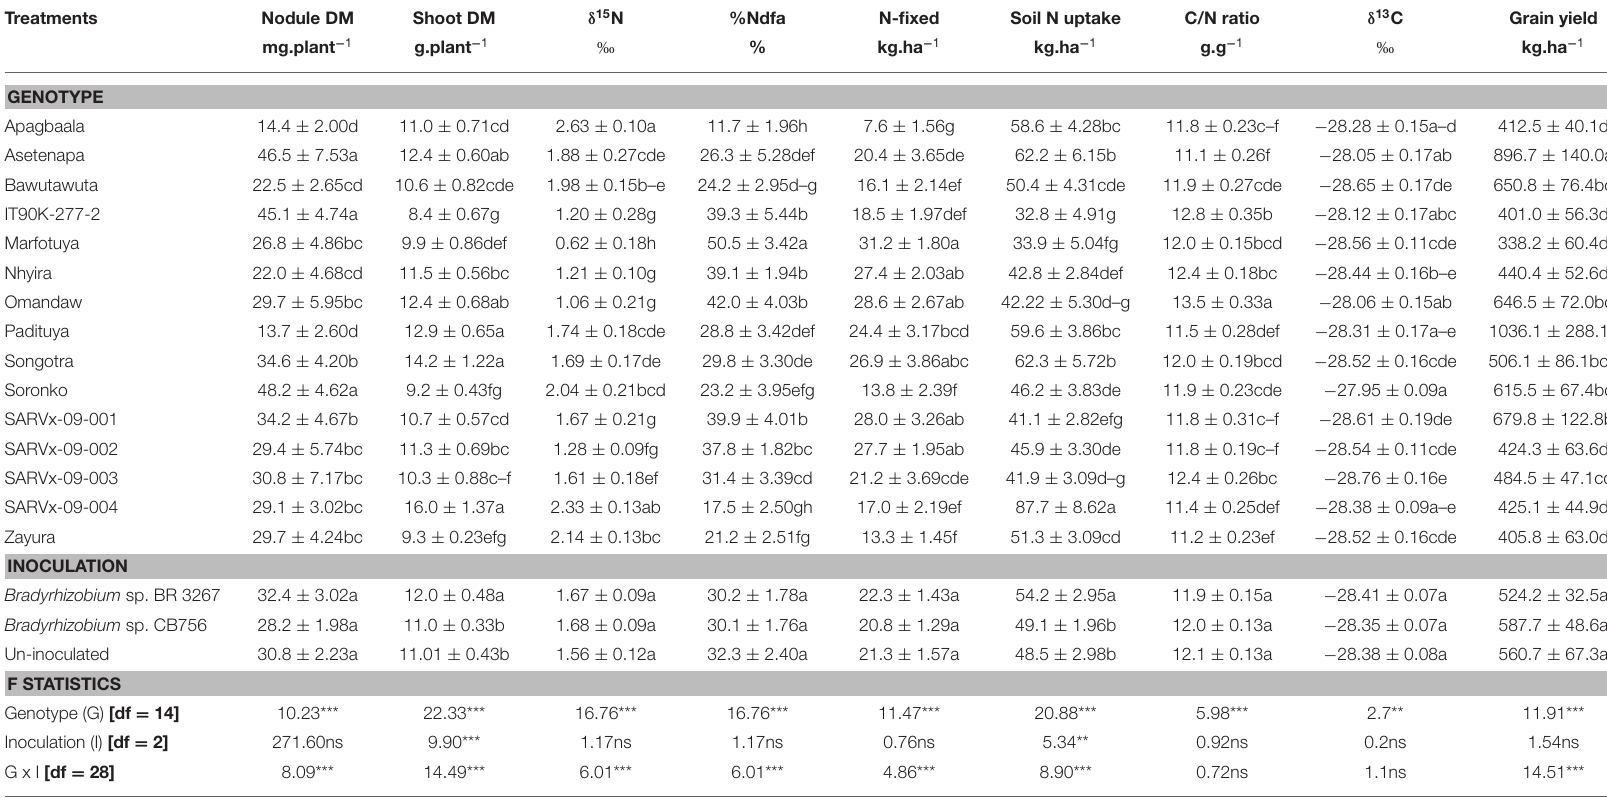
TABLE 3 | Nodulation, shoot dry matter (DM), symbiotic parameters, soil N uptake, δ 13 C, and grain yield of 15 cowpea genotypes inoculated with two Bradyrhizobium strains and planted in Savelugu in 2013.